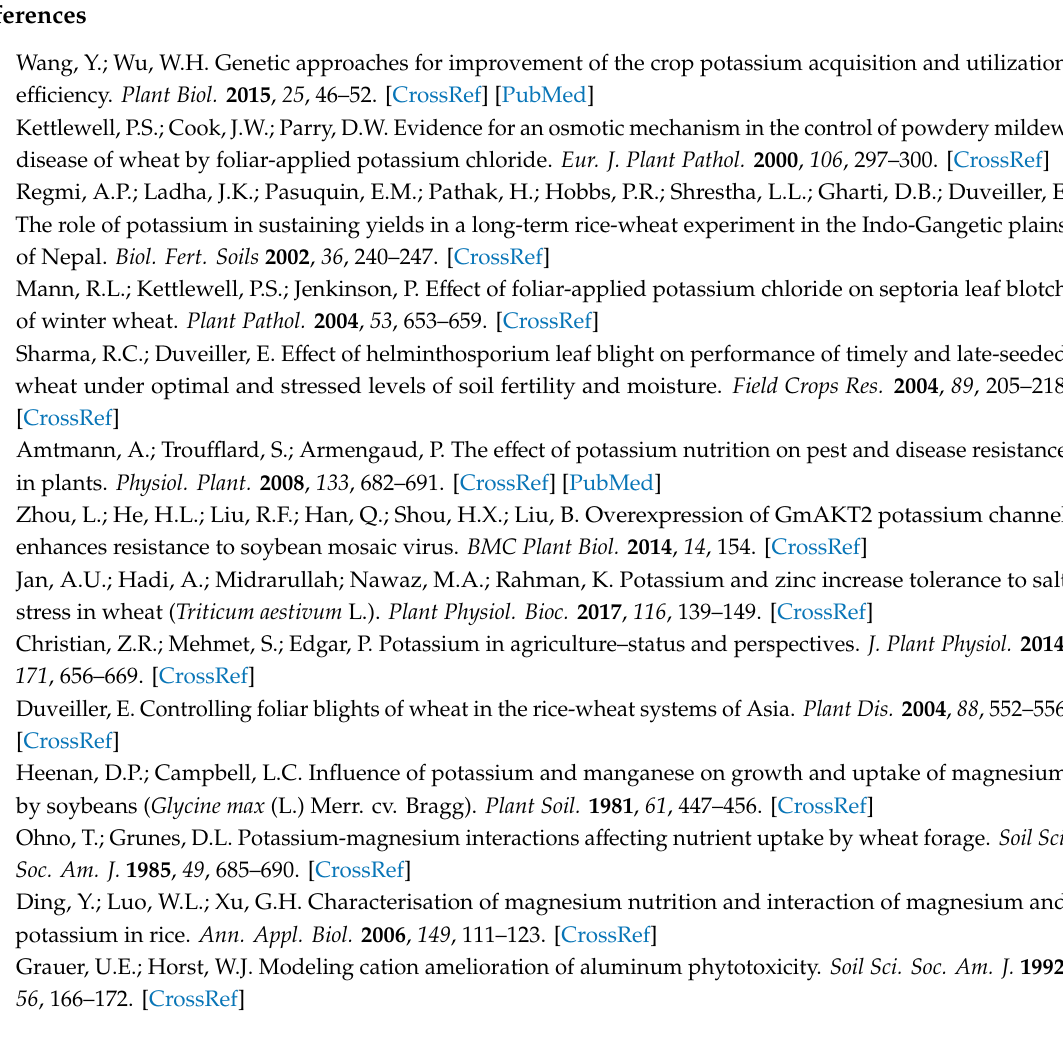
Table S1: Nutrient solution ingredients for wheat seedling growth under hydroponic culture, Table S2-1: Phenotypic performance of the RILs and their parents under hydroponic culture, Table S2-2: Phenotypic performance of the RILs and their parents under hydroponic culture, Table S2-3: Phenotypic performance of the RILs and their parents under hydroponic culture, Table S2-4: Phenotypic performance of the RILs and their parents under hydroponic culture, Table S2-5: Phenotypic performance of the RILs and their parents under field trials, Table S2-6: Phenotypic performance of the RILs and their parents under field trials, Table S2-7: Phenotypic performance of the RILs and their parents under field trials, Table S2-8: Phenotypic performance of the RILs and their parents under field trials, Table S3 − 1: Analysis of variance (F values) of the RIL population for investigated traits under hydroponic culture, Table S3-2: Analysis of variance (F values) of the RIL population for investigated traits under field trials, Table S4 − 1: Simple correlation coe ffi cients ( r ) between seedling traits of recombinant inbred line population, Table S4-2: Simple correlation coe ffi cients ( r ) between yield traits of recombinant inbred line population, Table S4-3: Simple correlation coe ffi cients ( r ) between yield and nutrient e ffi ciency traits of K, Ca, and Mg of recombinant inbred line population, Table S5: Additive QTLs detected in five K treatments under hydroponic culture and field